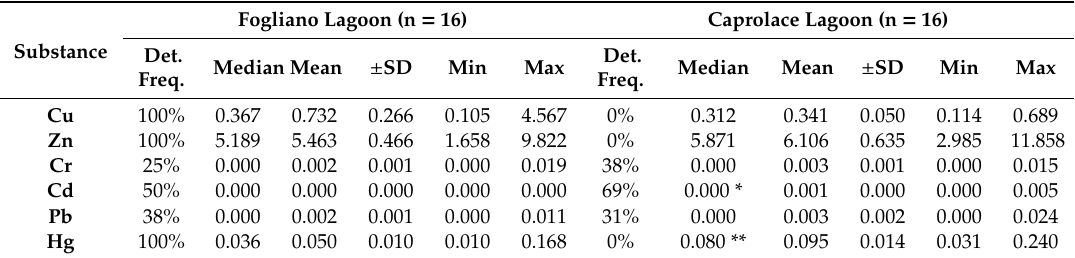
Table 5. Detection frequencies, medians, mean concentrations ( ± SD), and ranges of metals ( µ g g − 1 ww) detected in C. labrosus muscle from Fogliano and Caprolace. Fogliano Lagoon (n = 16) Caprolace Lagoon (n = 16) Substance Det. Median Mean ± SD Freq.